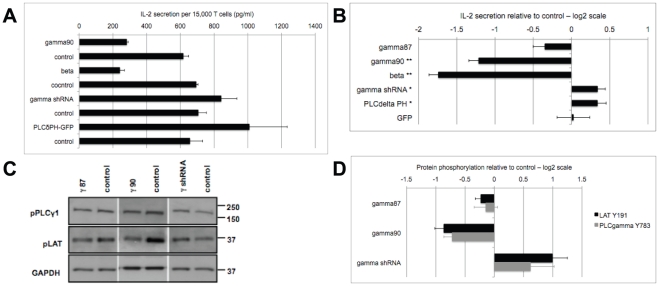
Manipulation of PIP5K expression affects IL-2 secretion and proximal signal transduction.
A, B. 5C.C7 T cells were activated by CH27 APCs and 10 µM MCC agonist peptide for 16 h upon manipulation of PIP5K expression and PIP2 blockade as indicated. Cell culture supernatants were analyzed for IL-2 by ELISA. A representative IL-2 ELISA is given in (A). Changes in IL-2 secretion upon manipulation of PIP5K expression and PIP2 blockade relative to non-transduced T cells are given with standard errors in (B) on a logarithmic scale to comparably display reduction and enhancement. ‘GFP’ indicates retroviral expression of GFP as a control. One/two asterisks indicate significance versus non-transduced control with p<0.05/0.005, respectively. Data from 3–6 independent experiments are given. When the agonist peptide concentration during T cell activation was reduced to a limiting concentration, 0.1 µM, knockdown of PIP5K γ still did not result in impaired IL-2 secretion (Fig. S3). C, D. 5C.C7 T cells were activated by CH27 APCs and 10 µM MCC agonist peptide for 2 min upon manipulation of PIP5K expression as indicated. T cell/APC extracts were blotted for LAT Y191 and PLCγ Y783. A representative blot is given in (C). Changes in LAT and PLCγ phosphorylation upon manipulation of PIP5K expression relative to non-transduced T cells are given with standard errors in (D) on a logarithmic scale to comparably display reduction and enhancement. Data from 3–4 independent experiments are given.